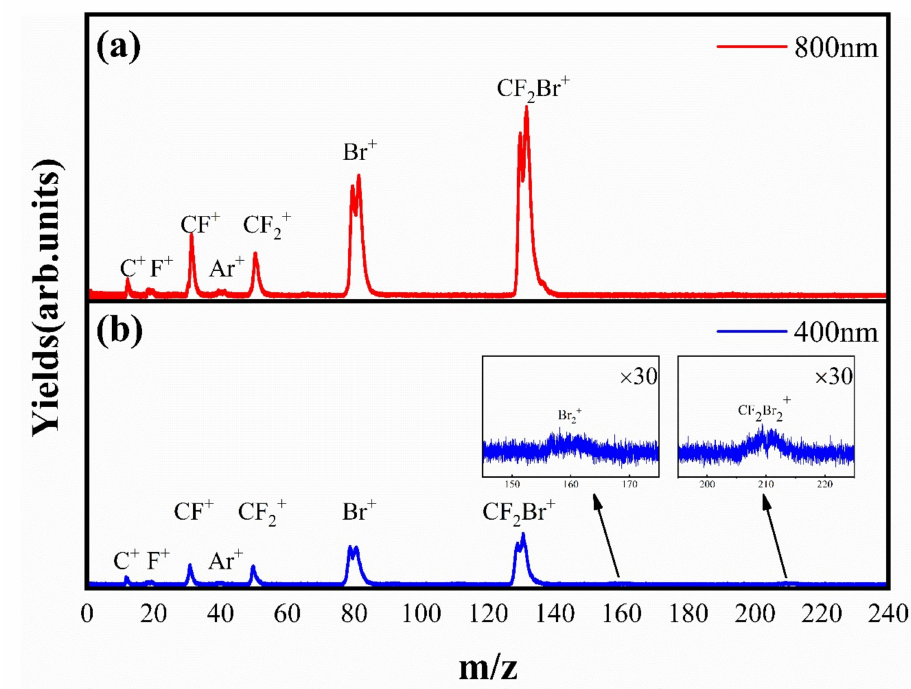
Figure 1. Time-of-flight (TOF) mass spectra of molecular CF 2 Br 2 at 2.5 × 10 14 W/cm 2 in 800 nm laser field ( a ) and 4.0 × 10 13 W/cm 2 in 400 nm laser field ( b ), respectively. The inset shows the signal of Br 2 + and CF 2 Br + ions magnified thirty